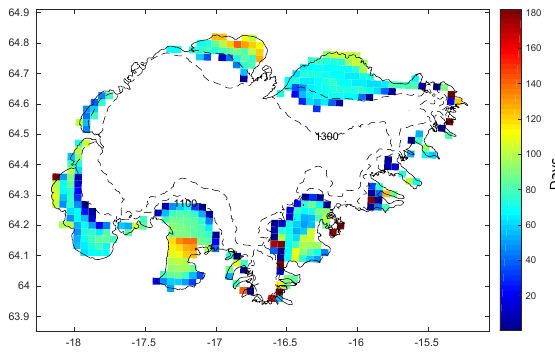
Figure 11. The average spread (max-min) in DOY when each ice point becomes snow-free when the summer weather is kept constant and the spring conditions are